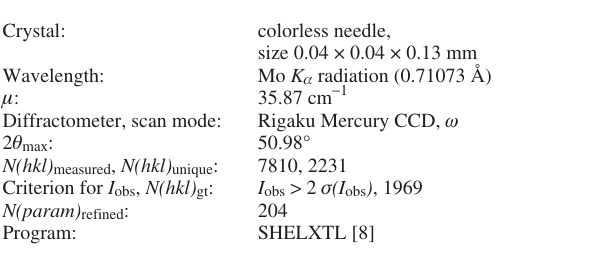
Table 1. Data collection and handling.